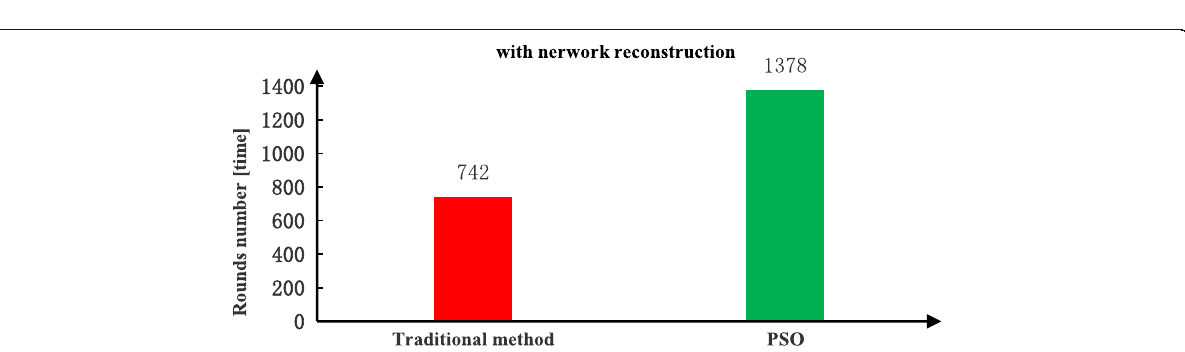
reconstruction method with fixed threshold is